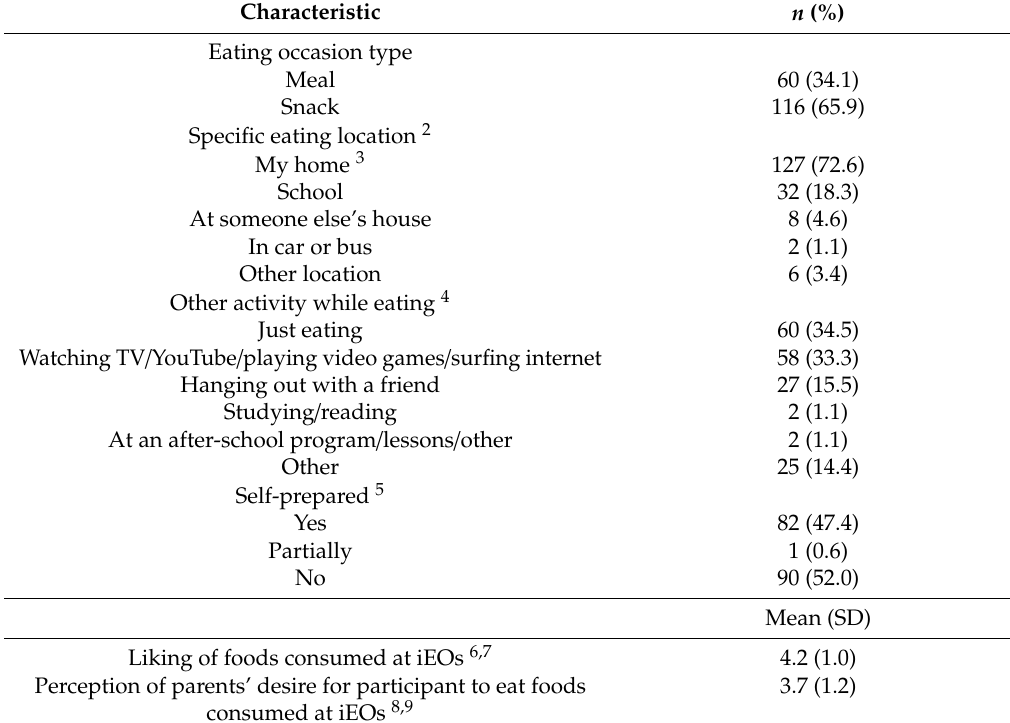
Table 3. General description of independent eating occasions (iEOs) among participants (10–13 years) 1